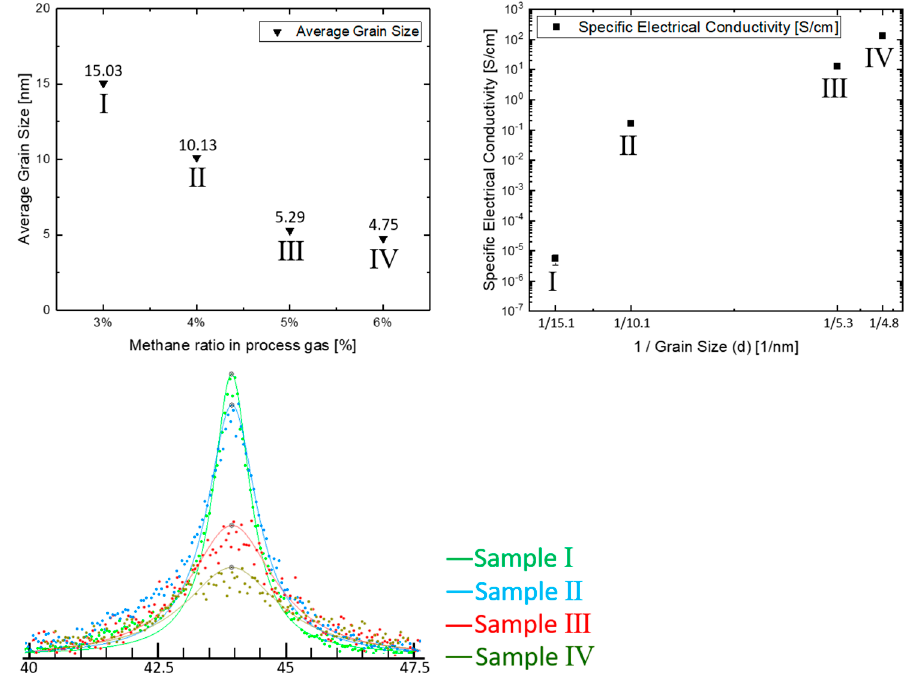
Figure 3. Evaluation of average grain size ( top-left ), specific electrical conductivity ( top right , evaluated with “4 points measurement”), and XRD-patterns ( bottom ) of four diamond film samples.